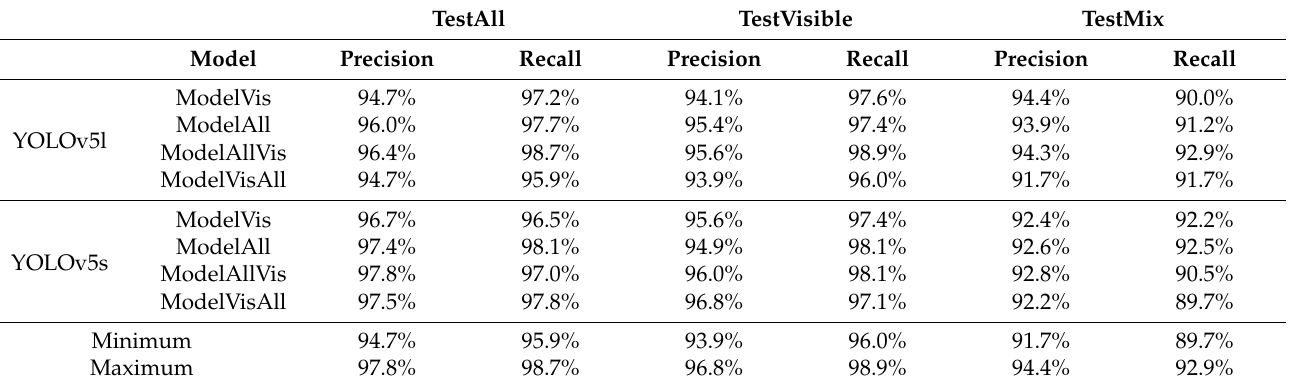
Figure 5. Sample image from the testDiff dataset containing only Betula grains with predicted bounding boxes: ( A ) ModelAll (YOLOv5s); ( B ) ModelVisAll (YOLOv5s). The measure mAP@.5:.95 allows validation of the classification with the assessment of the fitness of the bounding box to the detected object. In the case of monitoring, it is crucial to count the occurrences of all pollen grains of a given taxon, but their precise location is not a subject of importance. The prediction results are expressed by the performance measures described above, namely precision, recall, mAP.5, and mAP@.5:.95. The average precision and recall calculated from three repetitions separately for the testAll, testVisible, and testMix datasets are presented in Table 2. According to the model, average precision ranging from 91.7% to 97.8% was achieved, while the average recall values ranged from 89.7% to 98.9%. Table 2. Precision and recall averaged within three repetitions for the testAll, testVisible, and testMix datasets.